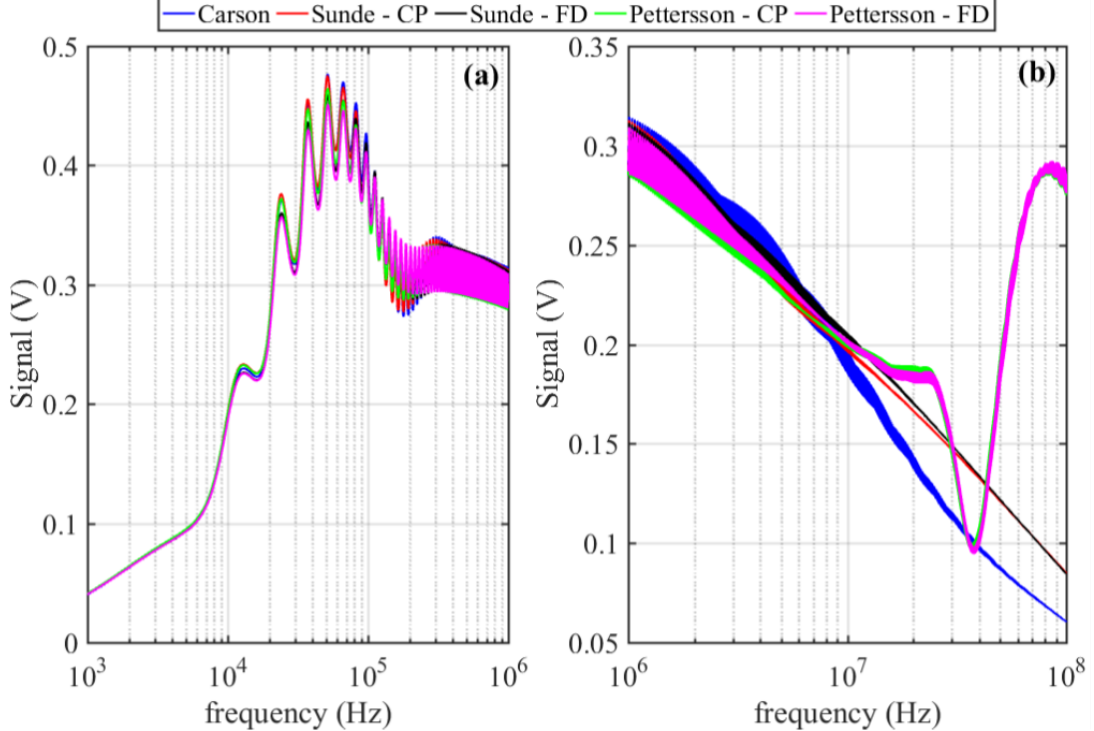
Figure 27. Crosstalk at the receiving end of phase b . Signal injection in ( a ) NB and ( b ) BB.